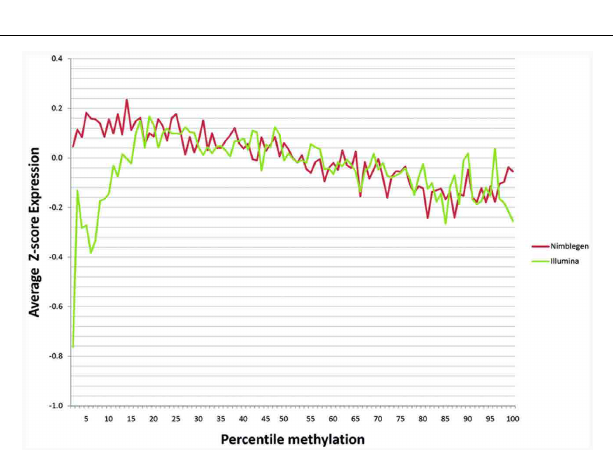
FIGURE 3 |The relationship of gene methylation to gene expression for the NimbleGen (red line) and the Illumina platform (green line) at each percentile of the z -score of the gene expression